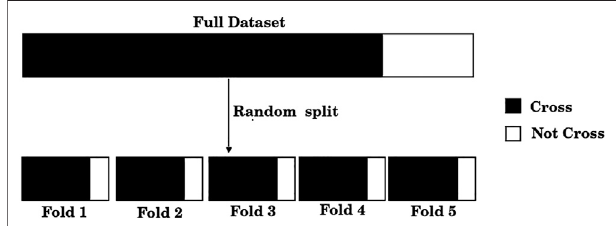
FIGURE 1 | The dataset of 248 compounds was divided randomly into fi vefolds.Eachofthesefoldspresents,approximately,thesamedistributionof positive and negative samples as the full dataset. times) and in the test set (once).